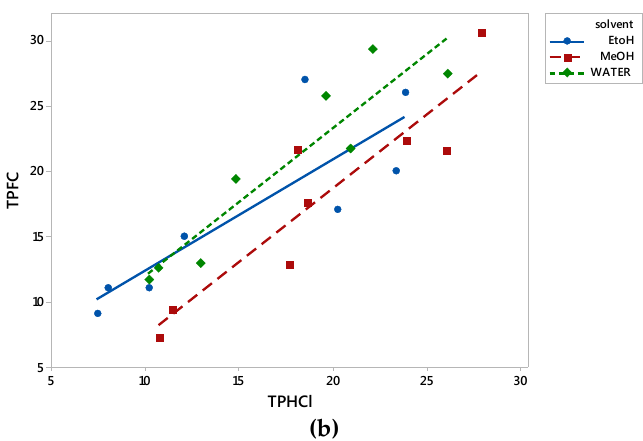
Figure 1. Correlation between TPFC and TPHCl data for all examined extracts. ( a ) W-indicates aqueous, M-methanol, and E-ethanol OLF extracts, respectively. ( b ) Data for aqueous, methanol and ethanol OLF extracts are depicted with green dashed line fitted in rectangles, red dashed line fitted in squares, and blue solid line fitted in circles, respectively. TPFC, total phenols determined via the Folin–Ciocalteu assay; TPHCl, total phenols determined via the alternative spectrophotometric assay; OLF, olive leaf samples.